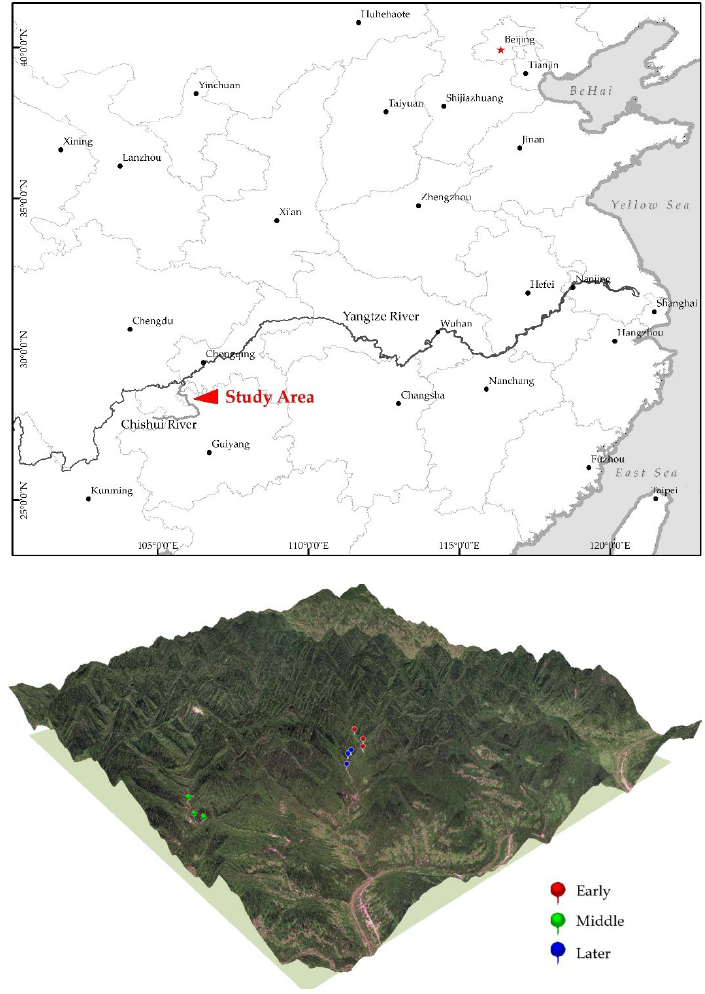
Figure 1. Location of study area and 3D sketch map of study plot. These maps were produced by ArcGIS software (ArcMap 10.4 and ArcScene 10.0, ESRI,